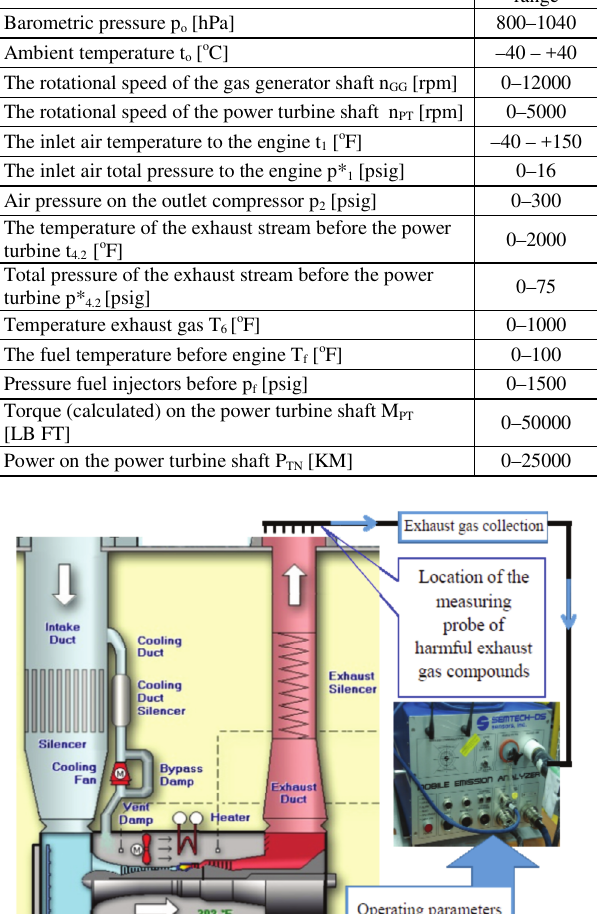
Fig. 3. Schematic diagram of LM 2500 gas turbine engine